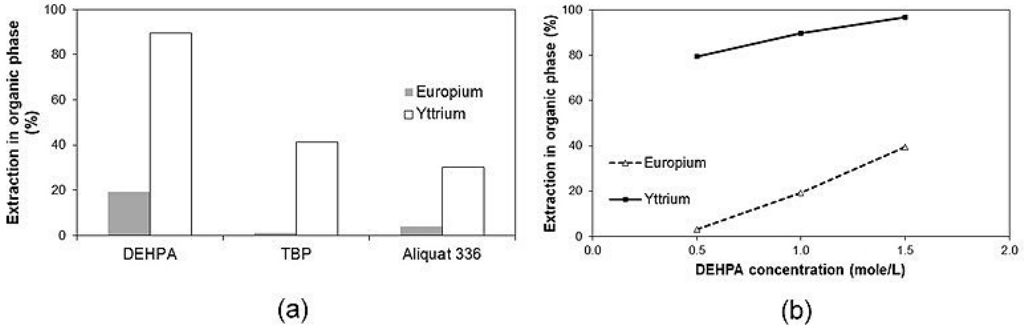
Figure 3. ( a ) Recovery of europium and yttrium in the organic phase with different extractant agents (extractants concentration in n -heptane: 1 M); ( b ) Recovery of europium and yttrium at different concentrations of di-(2-ethylhexyl) phosphoric acid